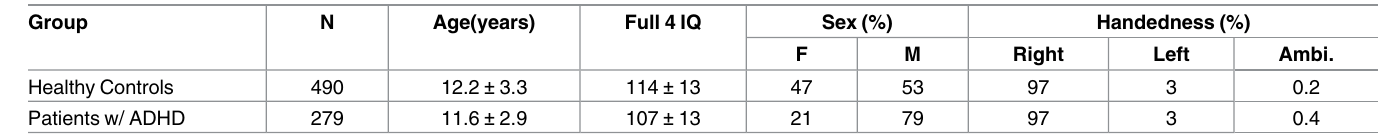
Table 1. Details of Training Datasetparticipants, ADHD-200.